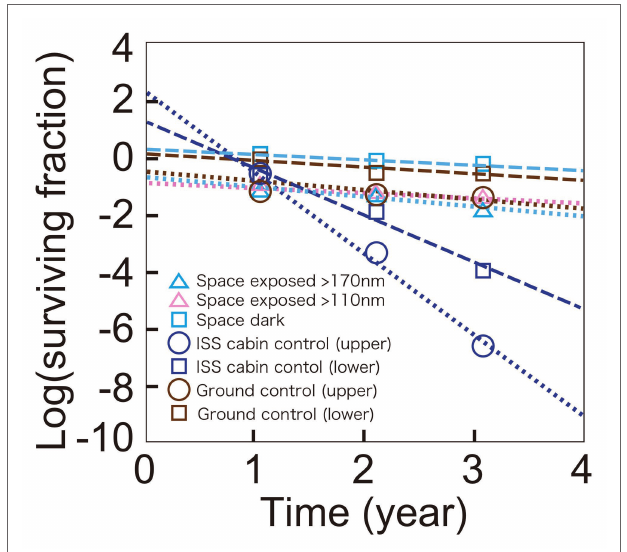
FIGURE 3 | Time course of survival of D. radiodurans R1 exposed to space at UV >170 nm (pale blue triangles) or UV >110 nm (pink triangles), or kept in the dark (pale blue squares). The ISS cabin upper (blue circles), lower (blue squares), and the ground upper (brown circles) and lower (brown squares) controls are also shown. Data of upper plate samples are connected by dotted lines. Data of lower plate samples are shown in squares and connected by dashed lines. The data of 1,000- μ m thick samples are shown. The actual thicknesses of the samples are presented in Supplementary Table 1 . Each mark shows the mean of triplicate samples; SEM was small and covered by data markers.